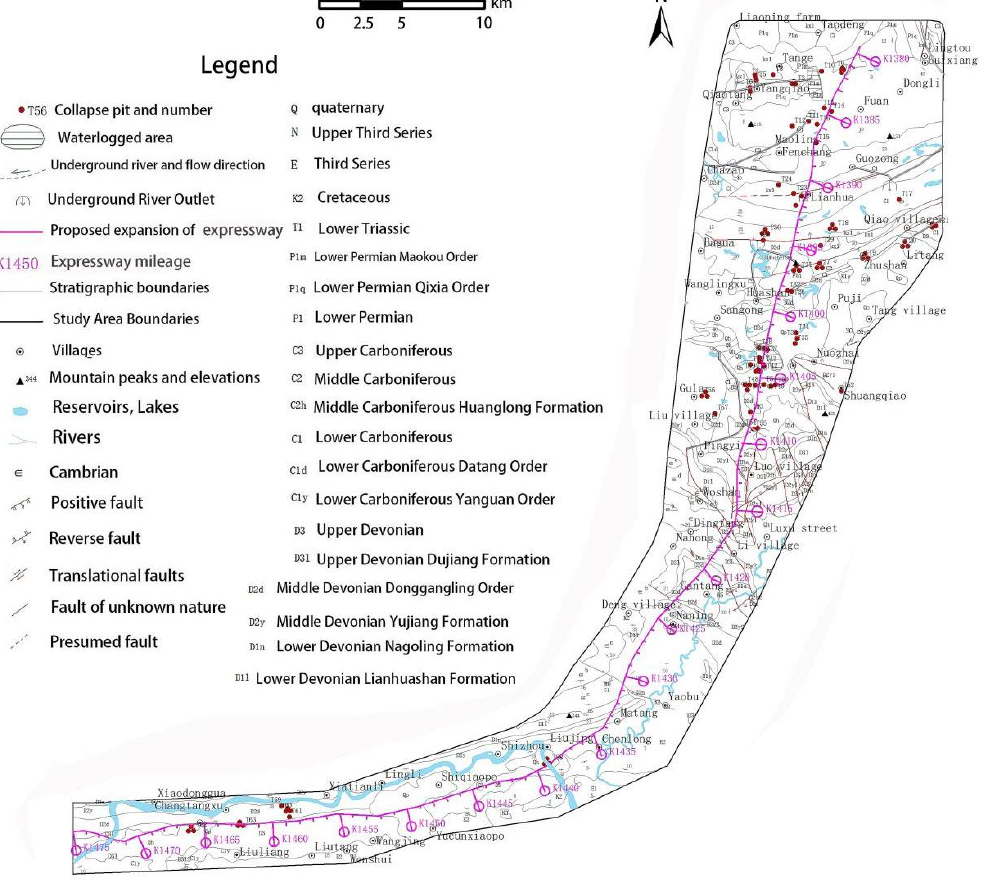
Figure 3. Engineering geological map of the study area.